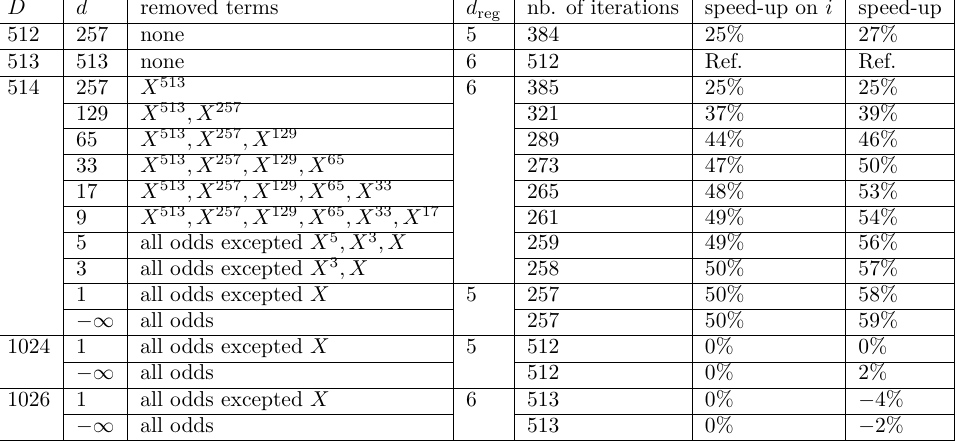
Table 11: Impact of d on the performance and on d reg the degree of